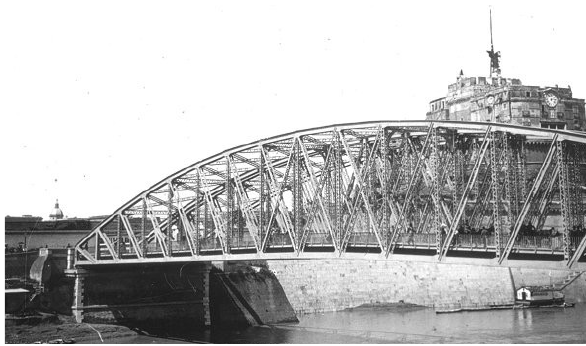
Figure 5. The temporary Alari Bridge near Castel Sant’Angelo (Postcard, 1899)